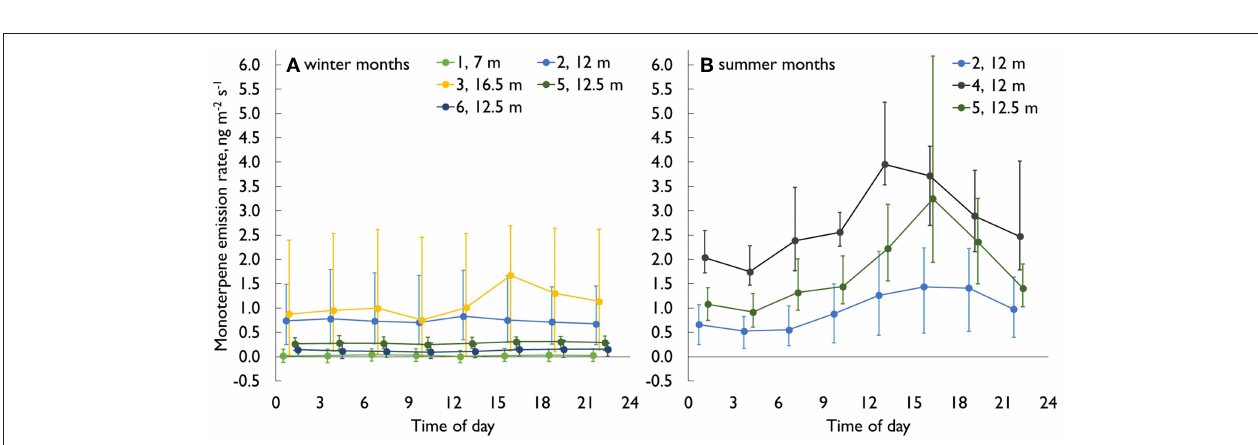
FIGURE 4 | The diurnal monoterpene emission dynamics (median, 25 and 75% percentiles) in Scots pine stem enclosures. (A) Winter months (Dec–Feb), (B) summer months (Jun–Aug). Colors indicate different chambers at different heights, chamber numbering (see Figure 1 ).